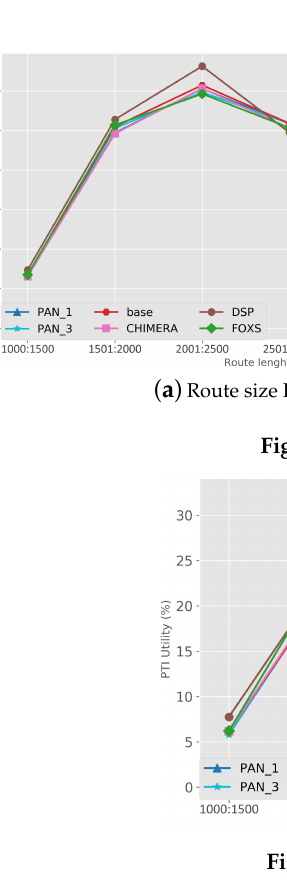
Figure 11. PTI by route size—Ottawa Scenario.